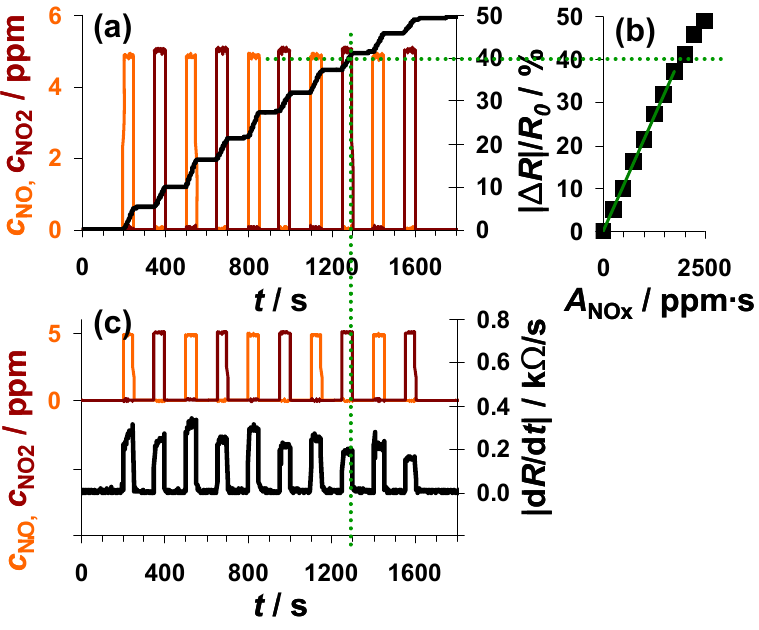
Figure 6. Sensor response on alternating pulses of 5 ppm NO (orange) and 5 ppm NO (red) for 50